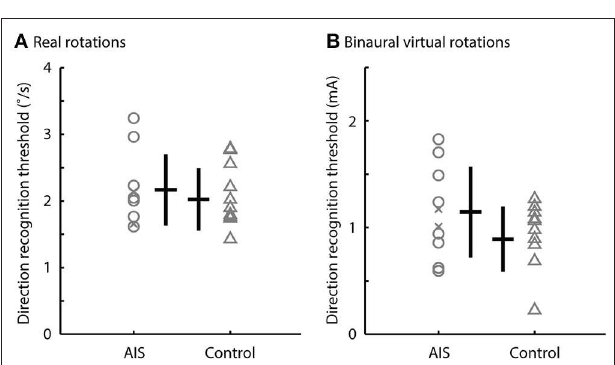
FIGURE 4 | Direction recognition thresholds to real rotations and binaural virtual rotations. Comparisons of the direction recognition thresholds for (A) the real rotations and (B) the binaural virtual rotations generated by the EVS. There was no difference between the AIS subjects and controls ( p > 0.05). Gray markers show individual data; black bars show the median and interquartile range. Post-surgery subjects are shown by the x markers.